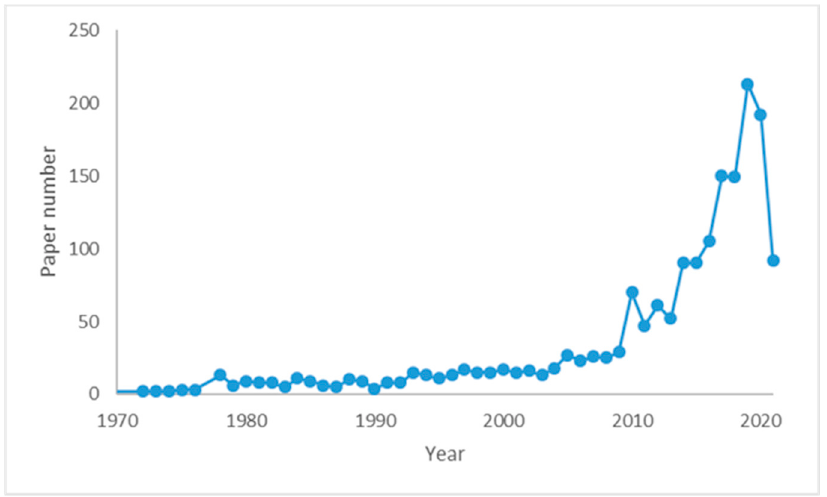
Figure 1. Yearly paper distribution mentioning district heating optimization (Scopus, May 2021) .